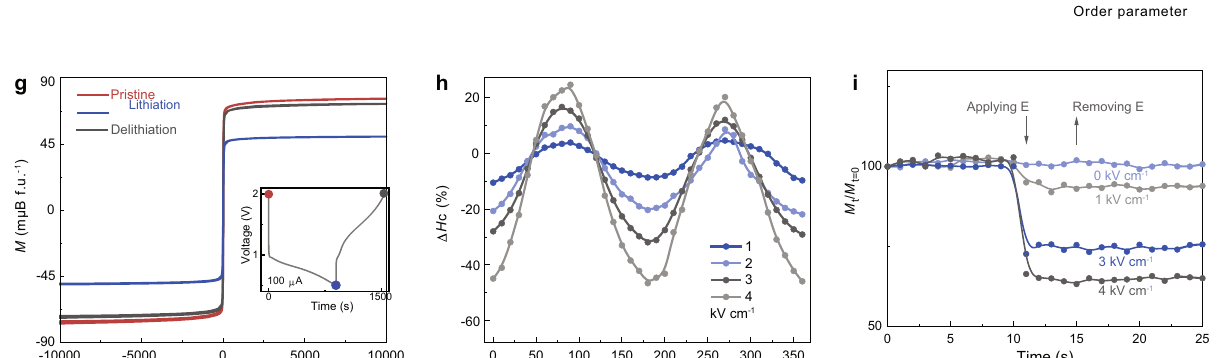
up to 1 V nm − 1 , coupling the dipole of IM and protons of VH 38 . The VH is surrounded by the IM phase under the ferroelectric fi eld effect (Fig. 4d). During the cooling process, the dipole order